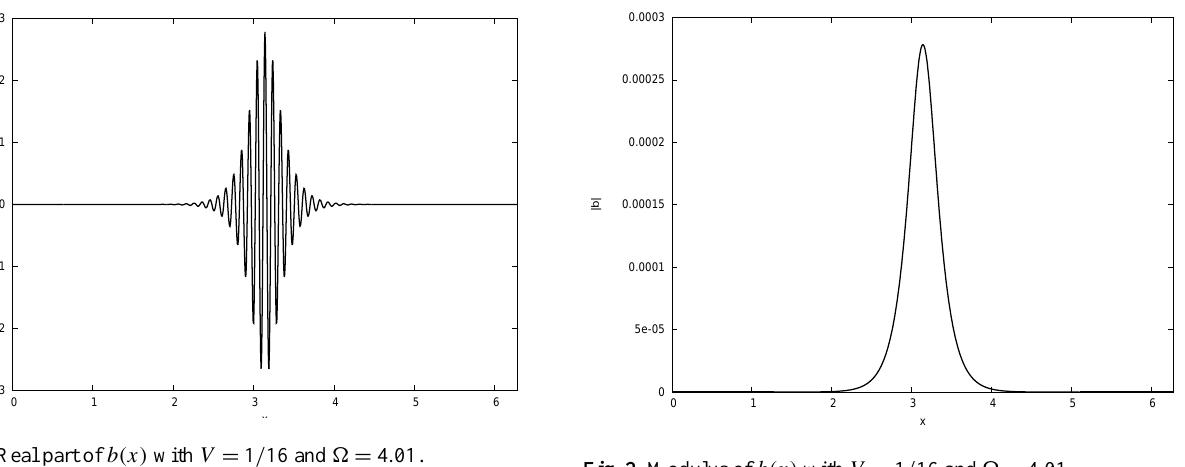
Fig. 2. Modulus of b(x) with V = 1 / 16 and (cid:127) = 4 . 01. Figure 2. Modulus of b ( x ) with V = 1 / 16 and Ω = 4 . 01.